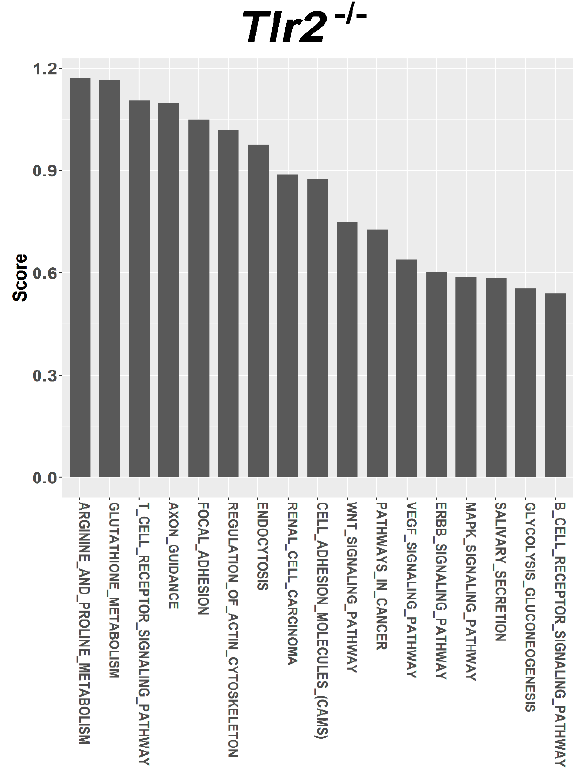
Figure 7. Pathway ranking summery of the genes by the dysregulated miRNAs from miRSystem database during weight reduction in Tlr 2 − / − mice. These pathways were annotated according to KEGG.